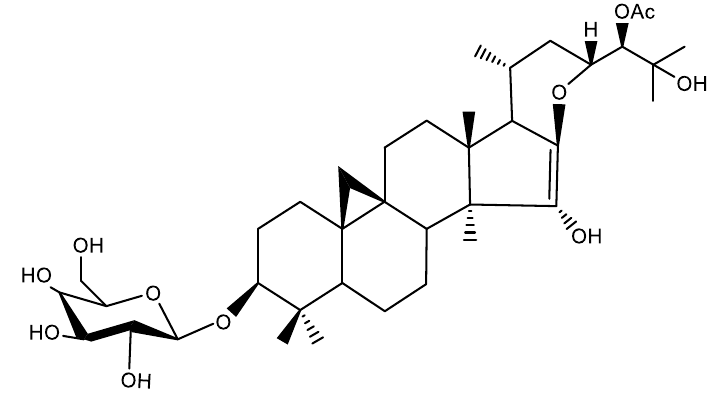
Figure 1. Structure of Shengmaxinside I.